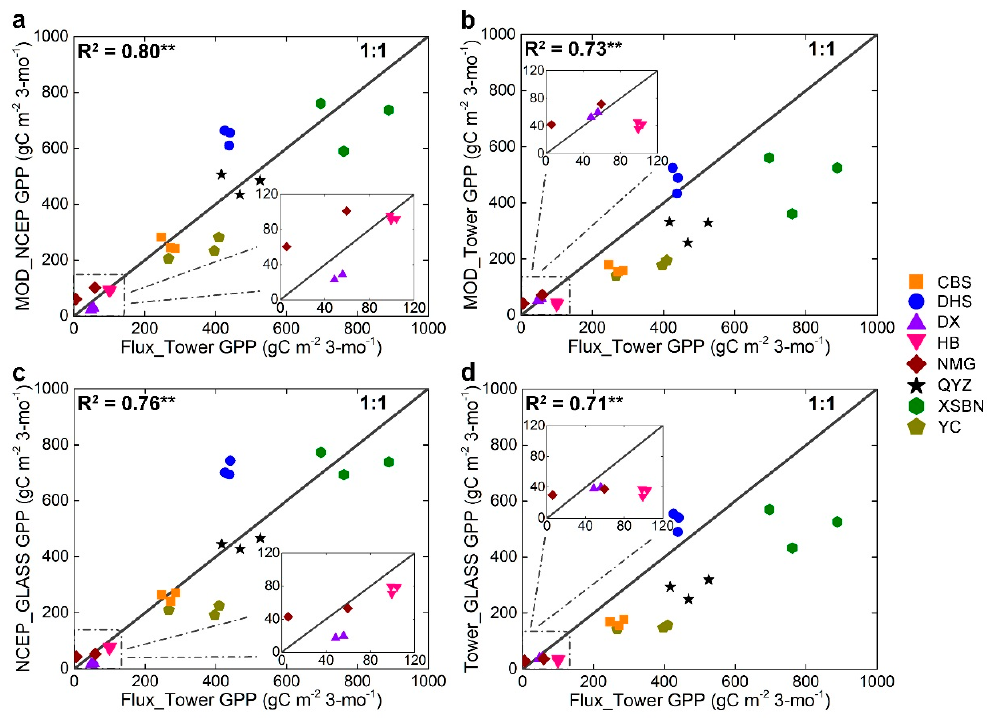
Figure 6. Comparisons of Flux_Tower GPP for autumn (September–November) with: ( a ) MOD_NCEP GPP; ( b ) MOD_Tower GPP; ( c ) NCEP_GLASS GPP; and ( d ) Tower_GLASS GPP. Significance levels: ** p < 0.01.